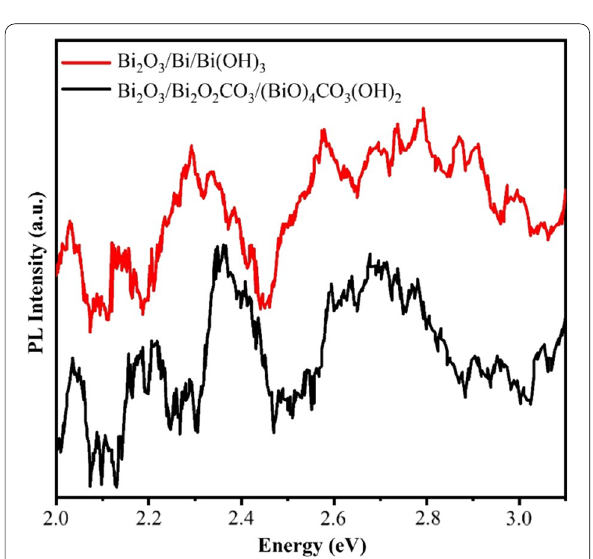
Fig. 11 Photoluminescence spectra of synthesized nanostructures by electrical arc discharge in urea solution and